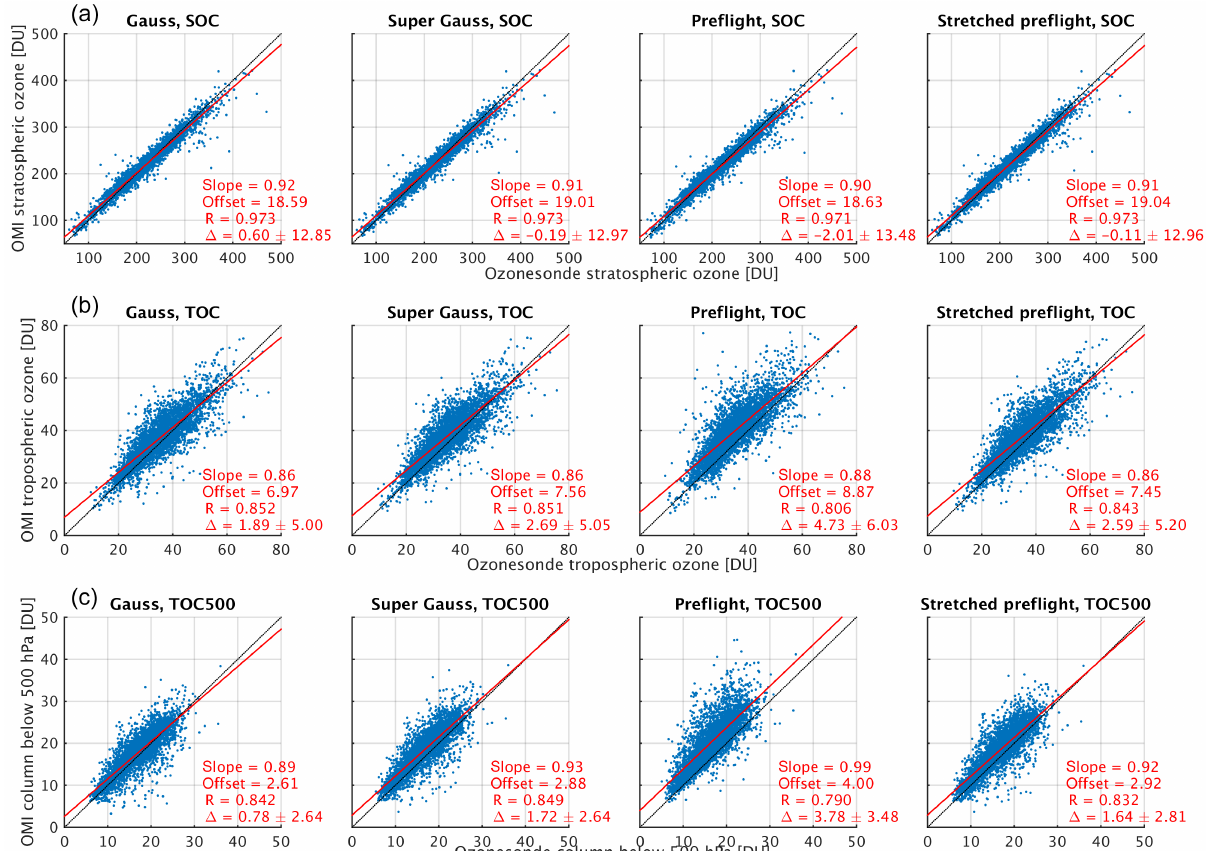
Figure 9. Scatter plots of OMI retrieved ozone partial columns vs. the ozonesonde data for SOC (a) , TOC (b) , and TOC500 (c) . The four columns represent retrievals using standard Gaussian, super-Gaussian, preflight, and stretched preflight slit functions. The slope and offset of the linear regression, correlation coefficient ( R ), and the mean bias ± 1 σ ( (cid:49) ) are shown for each subplot. The linear regressions are shown as red lines, and the black dash line is the 1 : 1 line. The number of successful validations is 4056 (same as for all slit functions; see Fig. 8).